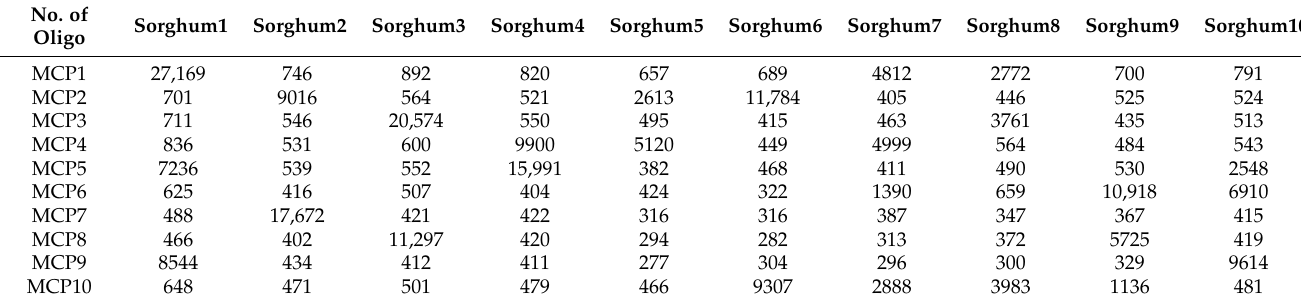
Table 1. The number of maize CP sequences aligned to each of the sorghum